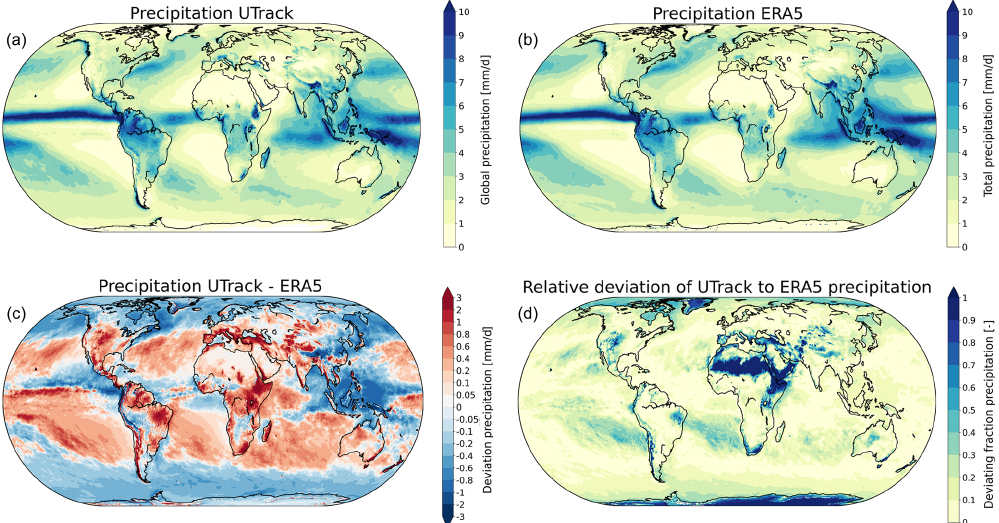
Figure 8. (a) Global precipitation (mmd − 1 ) during 2008–2017 derived from the moisture tracking model UTrack. (b) Global precipita- tion (mmd − 1 ) during 2008–2017 from the ERA5 dataset. (c) The absolute deviation of the precipitation from UTrack to that from ERA5 (mmd − 1 ). (d) The relative deviation of the precipitation from UTrack to that from ERA5 (deviation as fraction of ERA5